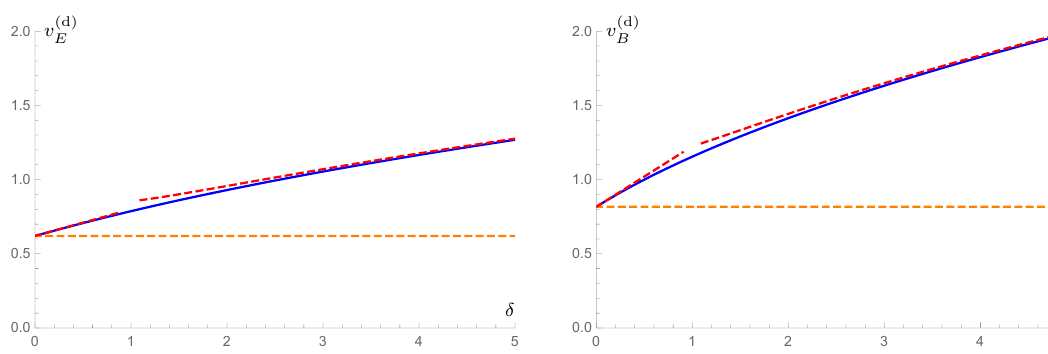
Figure 10 . Left: entanglement velocity and Right: butterfly velocity as a function of the dimen- sionless combination δ = λL 2 T 2 / 4 . In both plots we have shown in orange the standard values √ p v E = 2 / 3 3 / 4 ≈ 0 . 620 and v B = 2 / 3 ≈ 0 . 816 obtained in the limit δ → 0 , and the expansions for δ (cid:28) 1 and δ (cid:29) 1 , depicted in red. We notice that both velocities become superluminal at around δ ∼ O (1)